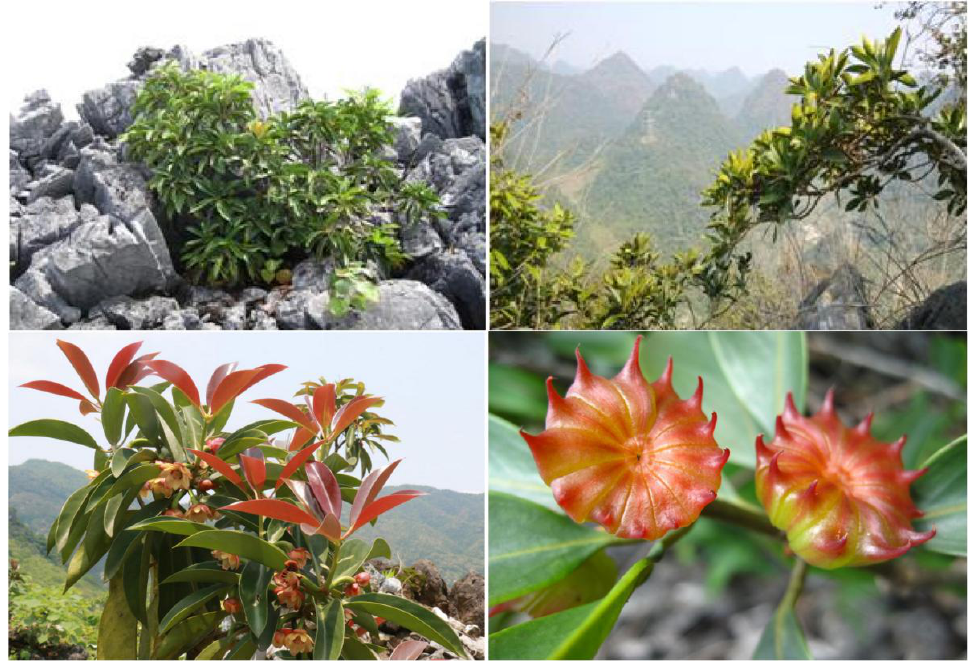
Figure 2. Natural habitat of I. difengpi (Illiciaceae) in China (adapted from Wang et al., with permission from Elsevier [3]). Copyright 2021